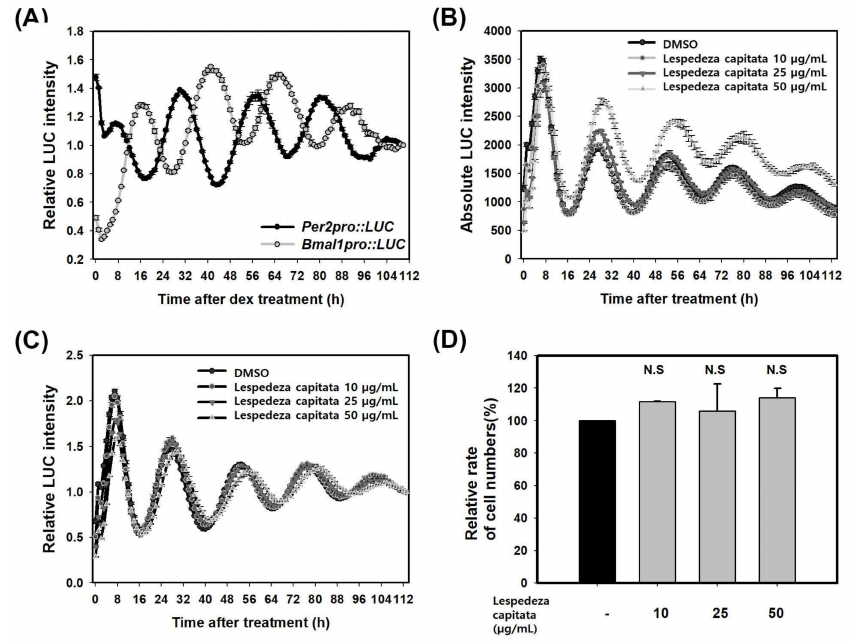
Figure 3. LCE increases PER promoter activity in HaCaT cells. ( A ) Per2pro::LUC and Bmal1pro::LUC reporter cell line.